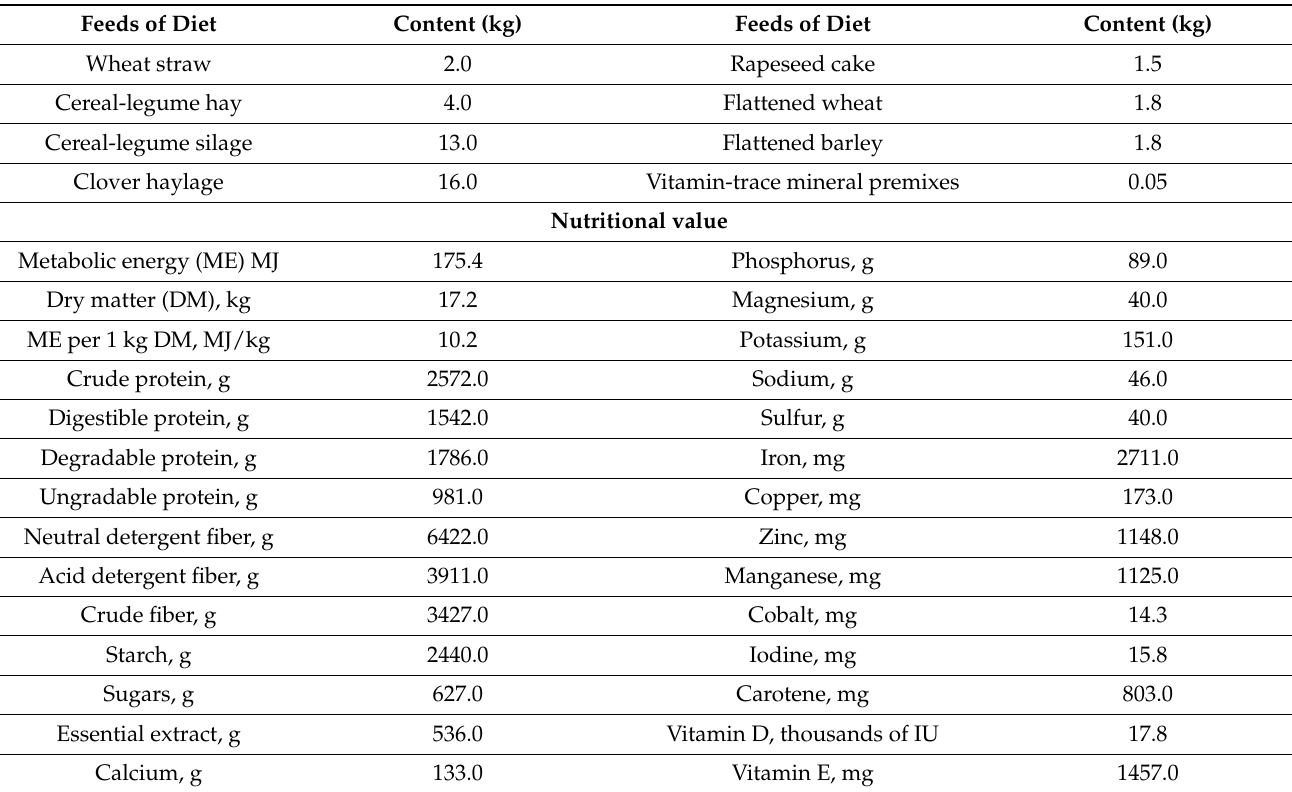
Table 2. Feed content in the ration and nutritional value of the diet lactating